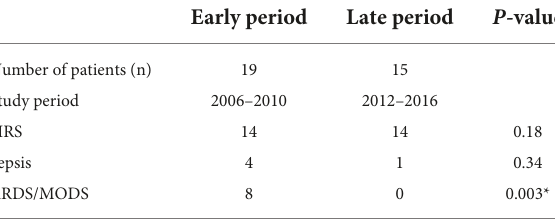
TABLE 1 Incidence of SIRS, sepsis and ARDS were tested using Fisher’s exact